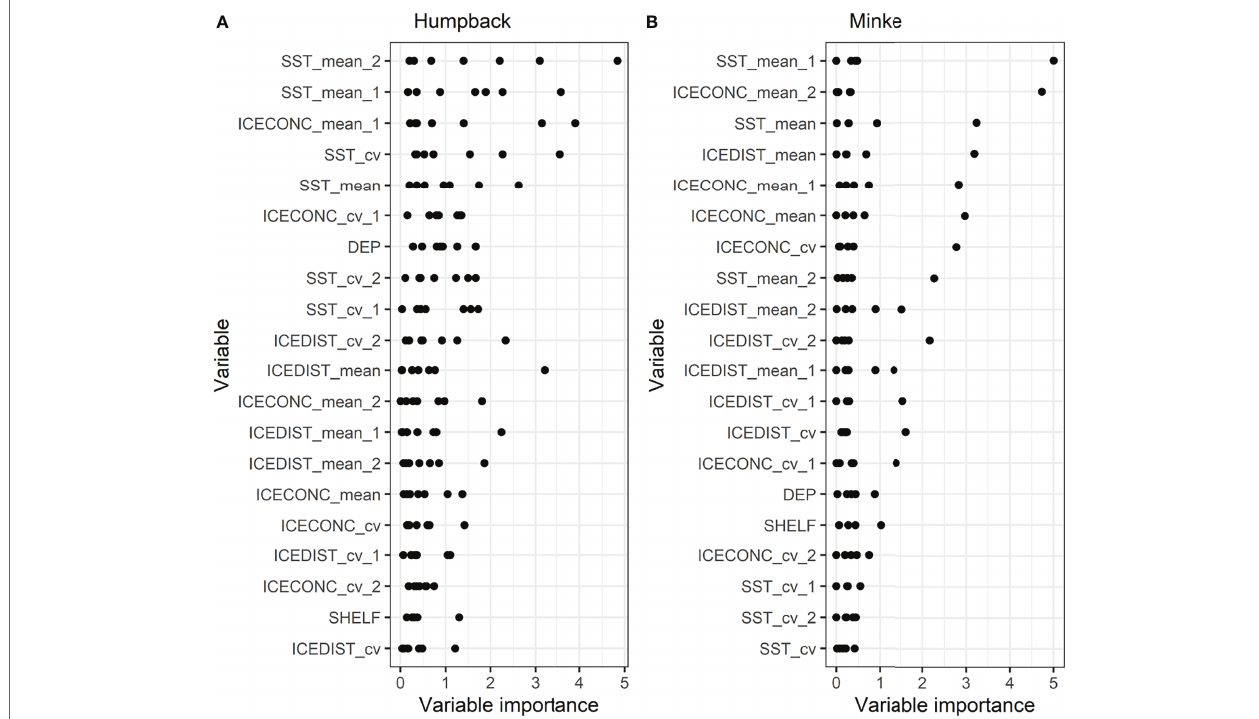
FIGURE 4 | Importance of environmental covariates in random forest models predicting the behavioural state of (A) humpback and (B) minke whales. Covariates are ordered from lowest (bottom) to highest (top) mean importance, with each point representing a monthly random forest model (seven models for humpback whales and five models for minke whales). SST_mean, mean sea surface temperature; SST_cv, coefficient of variation of sea surface temperature; ICECONC_cv, coefficient of variation of sea ice concentration; ICEDIST_mean, mean of distance to sea ice edge (15% sea ice concentration contour); ICECONC_mean, mean of sea ice concentration; DEP - ocean depth; SHELF, distance to shelf (500 m bathymetry contour); ICEDIST_cv, coefficient of variation of distance to sea ice edge (15% sea ice concentration contour). Suffixes _1 and _2 indicate 1- and 2-month time